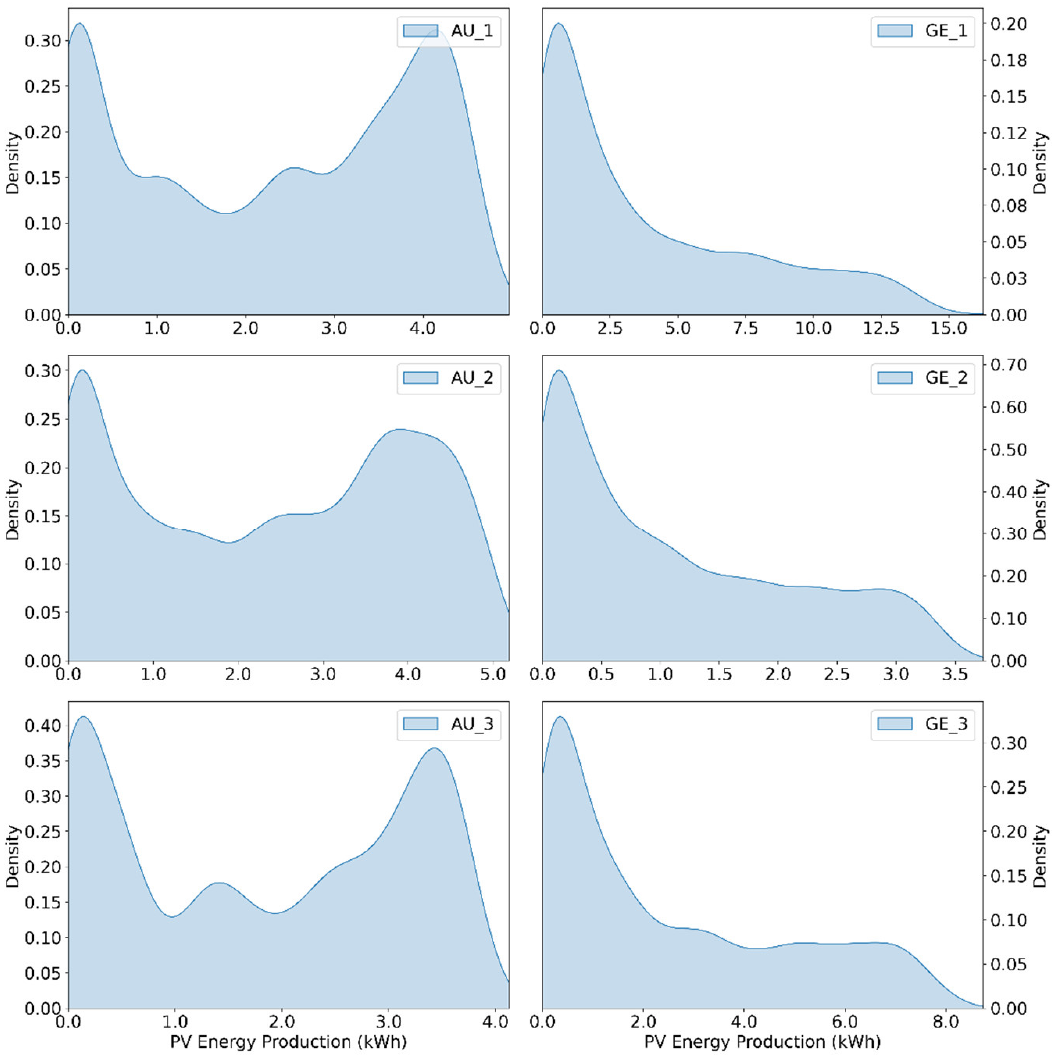
Figure 5. Probability density function (PDF) of the PV energy production for the different facilities .